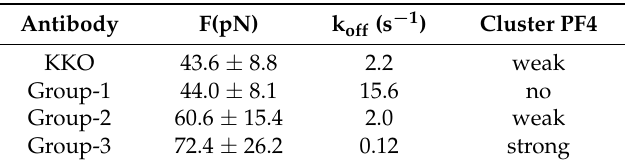
Table 1. Binding characteristics of aPF4/H